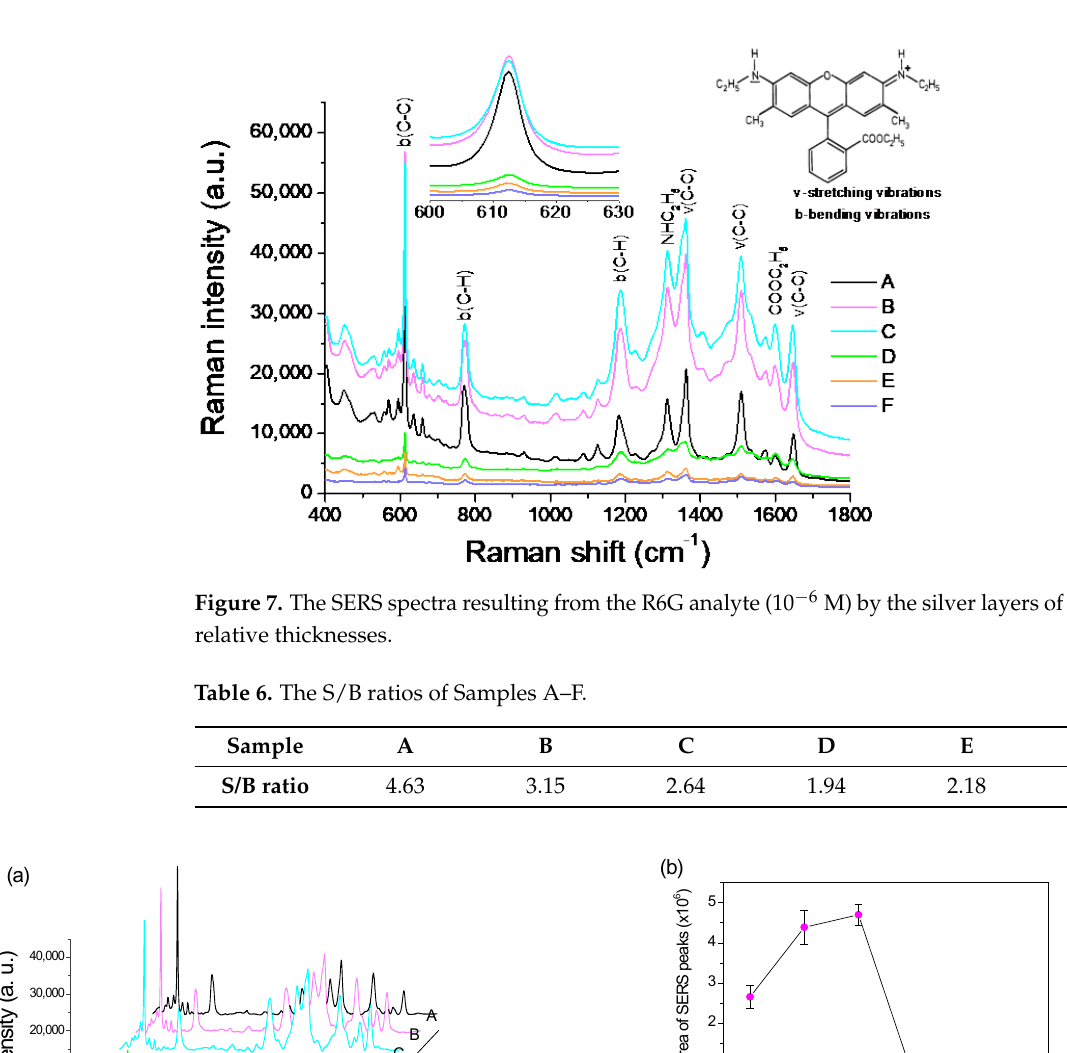
Table 6. The S/B ratios of Samples A–F.